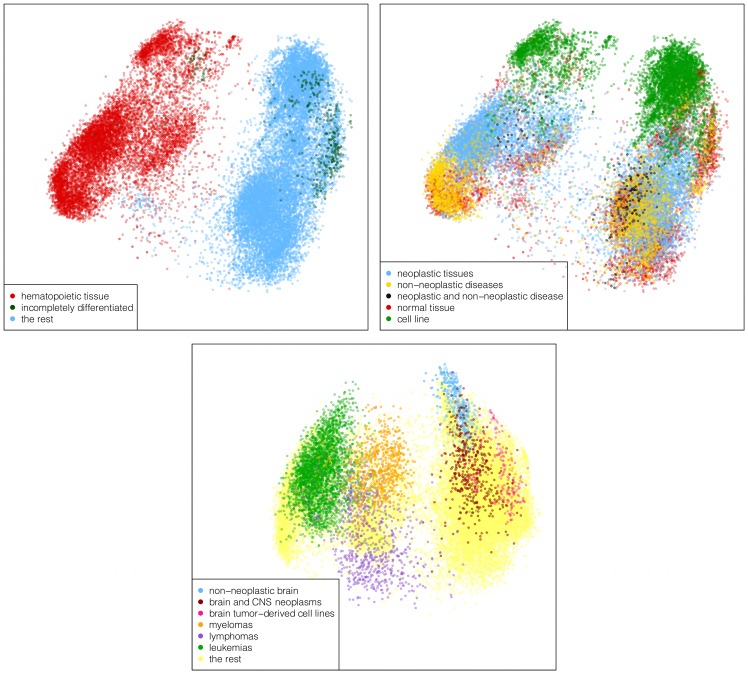
Principal components.On top, the first two principal components. The panel on the left illustrates the clear separation along the X-axis of the hematopoietic and non-hematopoietic material containing samples from both tissues and cell lines. The non-solid region includes blood, bone marrow, lymph nodes, tonsil, osteoclasts, spleen, sputum, thymus gland, bronchoalveolar lavage cells and derived cell lines. An elongated cluster including incompletely differentiated cells is also found. In the right panel, the Y-axis separates cell lines (top), neoplasias (middle) and non-neoplastic diseases (bottom), whereas normal tissues overlap with all three. The panel in the bottom shows the data for the first (X-axis) and third components (Y-axis). The hematopoietic axis (X-axis) allows detaching leukaemias from other blood neoplasias. Cell lines derived from brain tumours can be distinguished from their tissues of origin along this axis as well. The Y-axis detaches non-neoplastic central nervous system samples from tumoral ones, and separates myelomas from lymphomas.